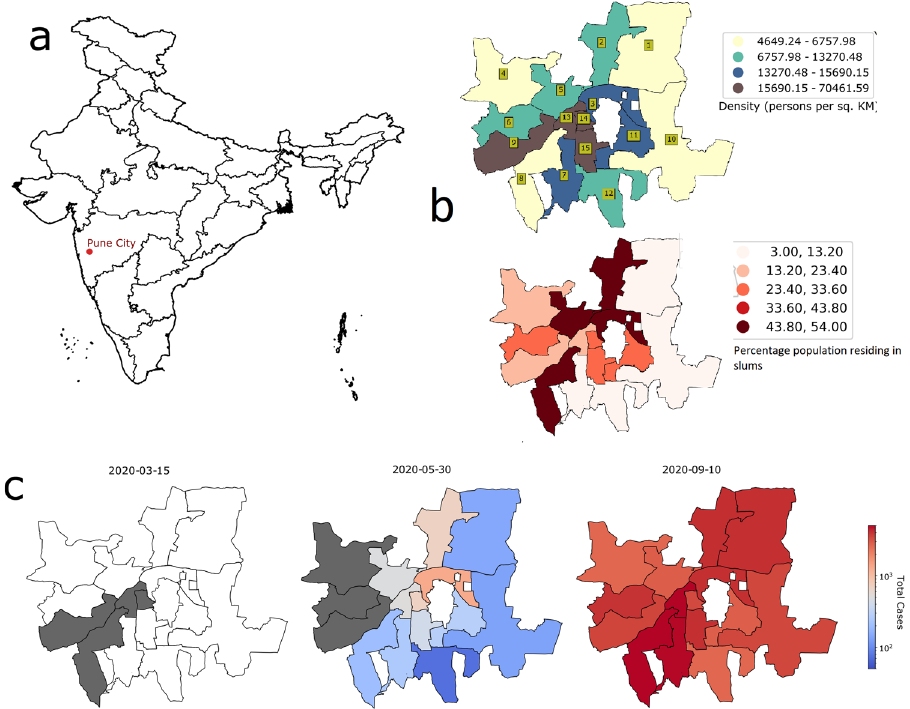
Figure 1. ( a ) Location of Pune City, India. ( b ) Geographic boundaries of ward offices located within Pune Municipal Corporation (PMC). Fill color indicates the quartile of population density (persons per square kilometer) and the proportion of slum population in each ward. Numbers inside the olive boxes indicate the official ward office number (see Supplemental Table S1 for the name corresponding to each ward office number). ( c ) the number of COVID-19 patients in each PMC ward office at beginning of the pandemic (left panel), at the end of the nationwide lockdown (middle panel), and at the end of the study period (right panel). The date is located at the top of each panel. Dark gray indicates < 50 patients, white indicates no patients, and the transition between blues and reds seen in the middle panel denotes approximately 600